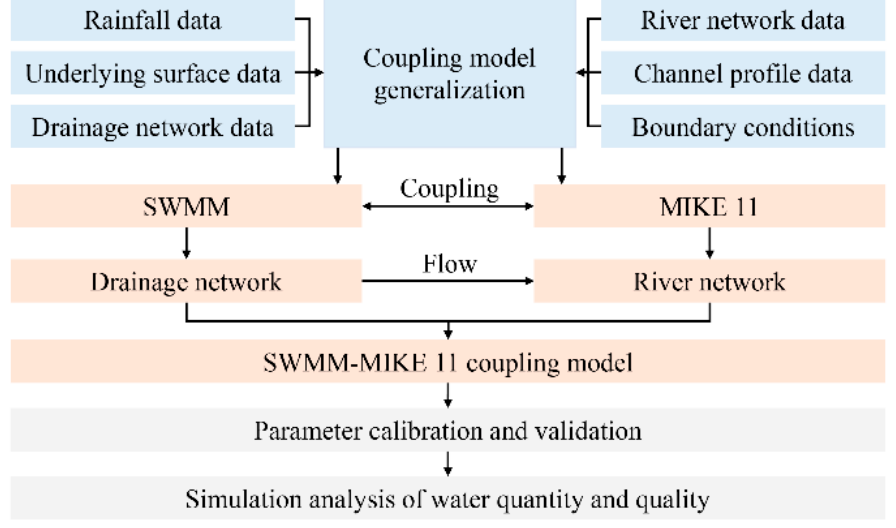
Figure 2. Coupling scheme of the SWMM and MIKE11 models.